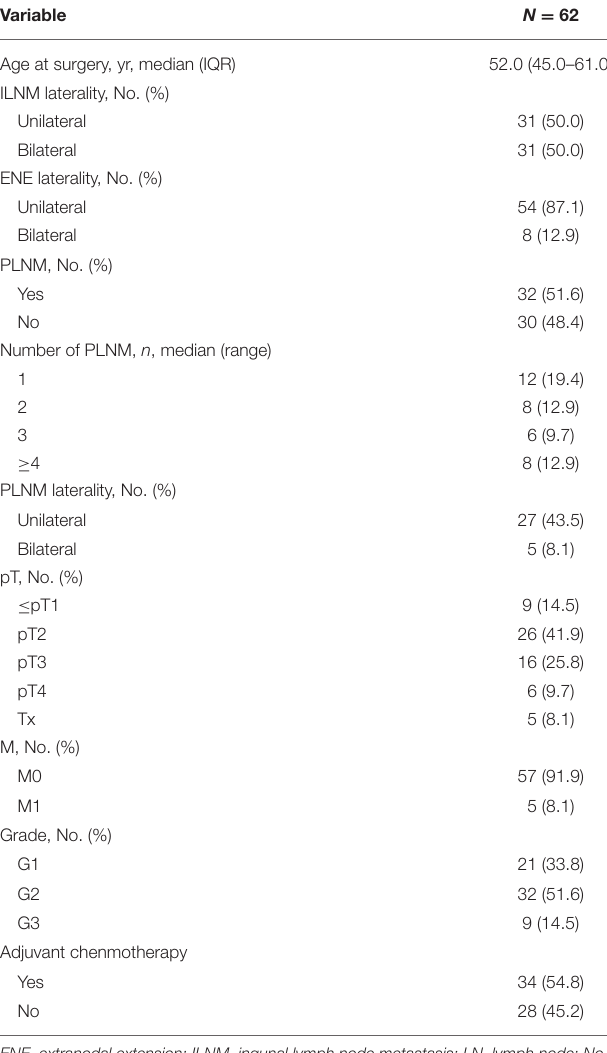
TABLE 1 | Clinical and pathological characteristics of the PSCC patients. Variable